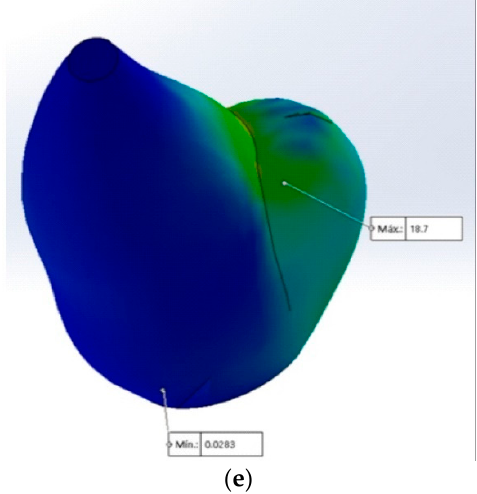
Figure A2. Maximun Stress in the crown with 150 N in connections: ( a ) External hexagon; ( b ) internal hexagon; ( c ) morse taper; ( d ) conical connection; ( e ) conical triangular connection.